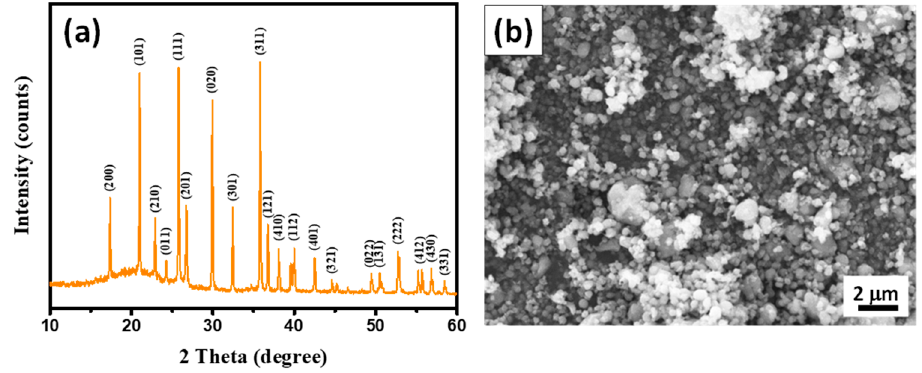
Figure 1. ( a ) Typical XRD pattern and ( b ) FE-SEM image of LFP powders.